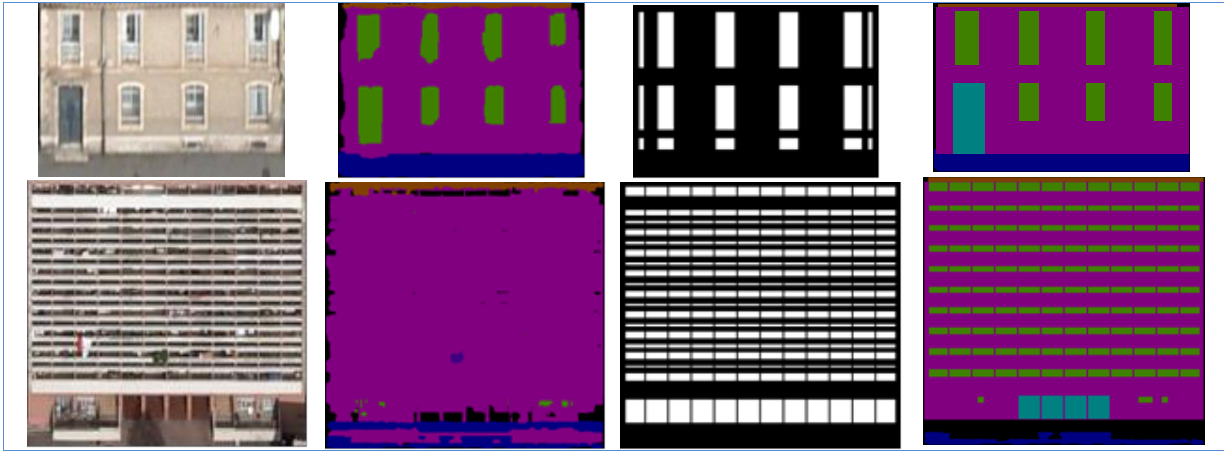
Figure 7: Original image; Pixel-based detection; Opening hypothesis using accumulation of gradient; Object-based